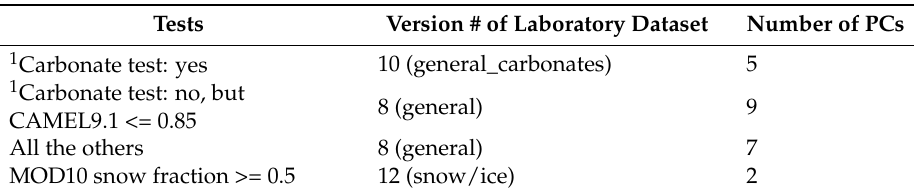
Table 2. Determination of the number of PCs and the version number of laboratory datasets for each pixel.